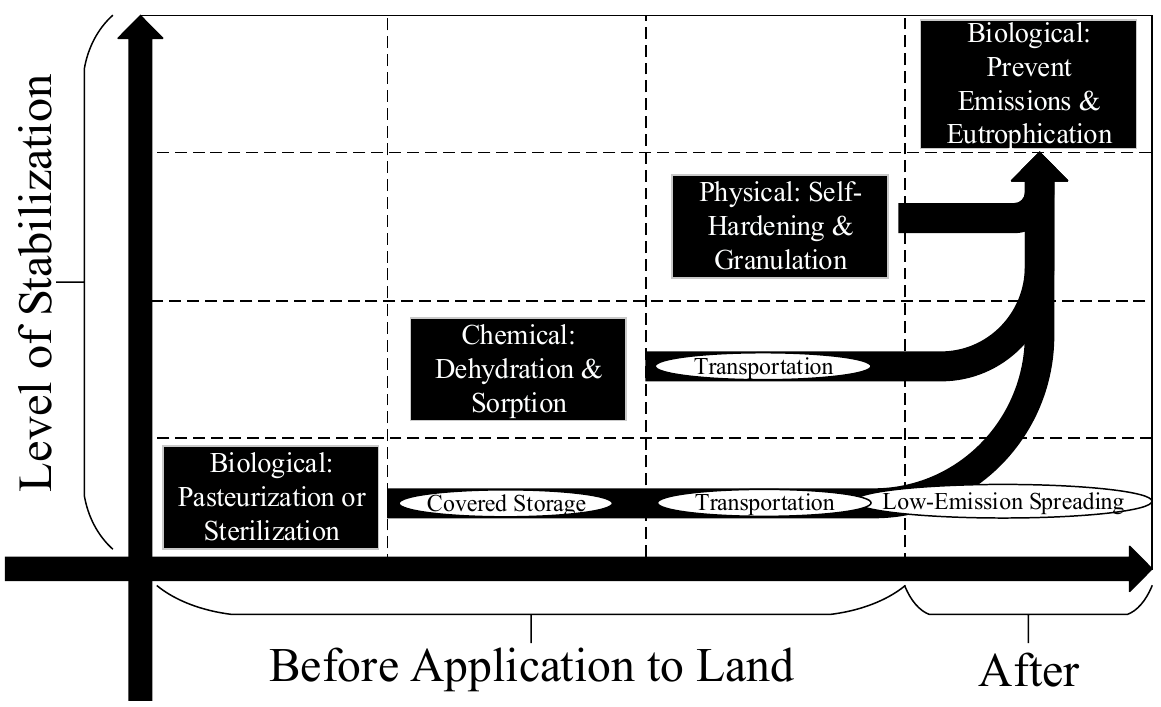
Figure 2. Different levels of stabilization of OS with 97% moisture [12] . Reproduced with the permission of the first author—A.M.A. and Elsevier Publishers, copyright granted on 13-02-2022. Source: Journal of Environmental Chemical Engineering (Elsevier).